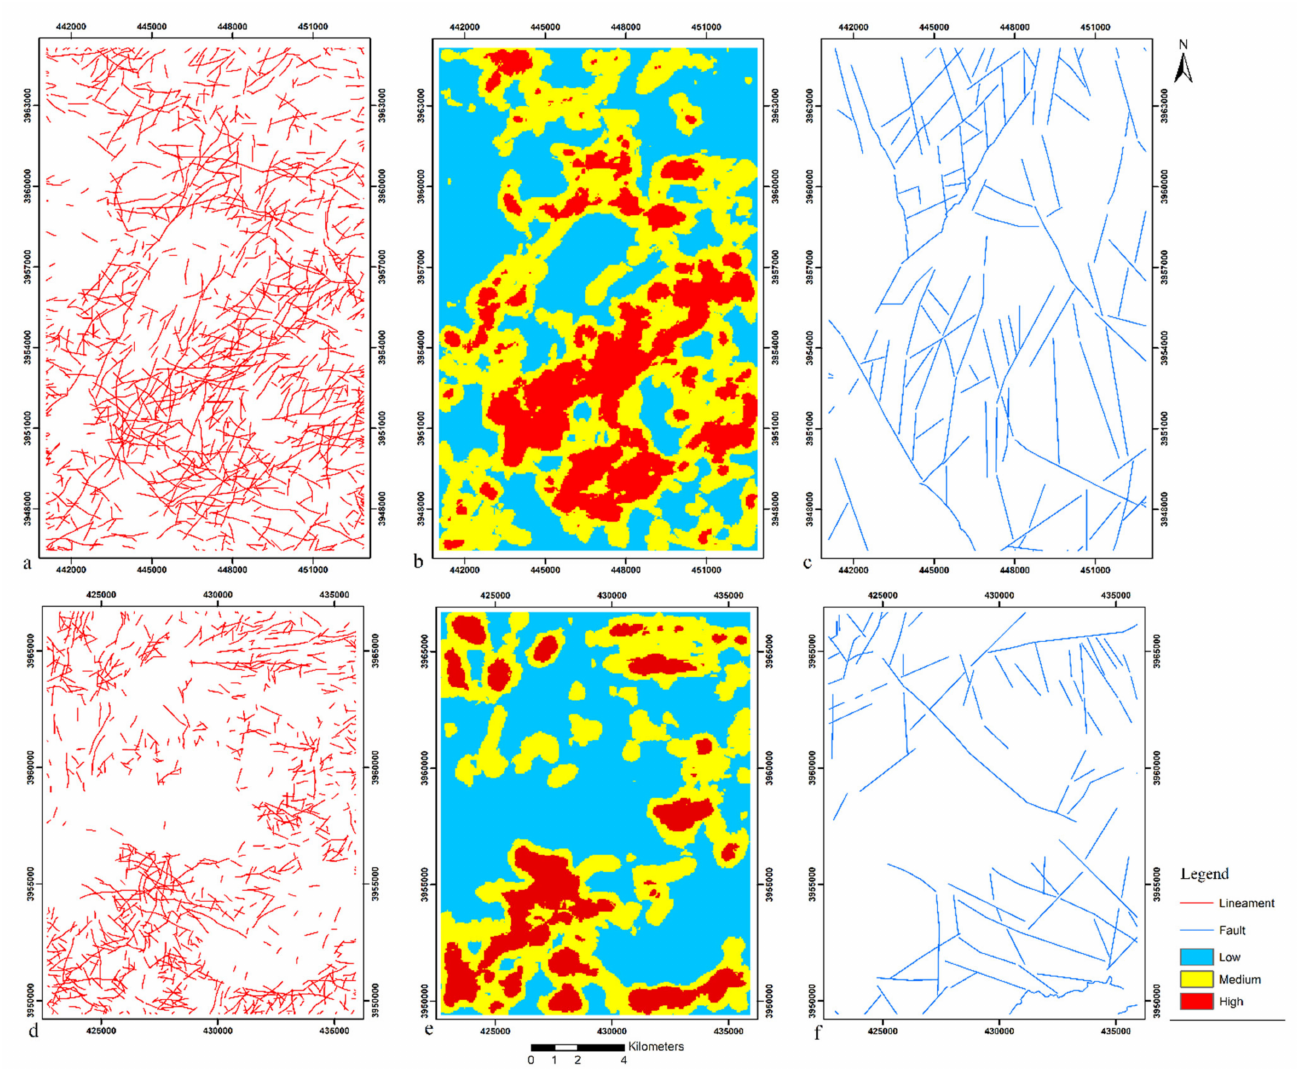
Figure 7. Maps of lineaments: ( a ) zone I and ( d ) zone II; lineaments density for ( b ) zone I and ( e ) zone II; existing faults for ( c ) zone I and ( f ) zone